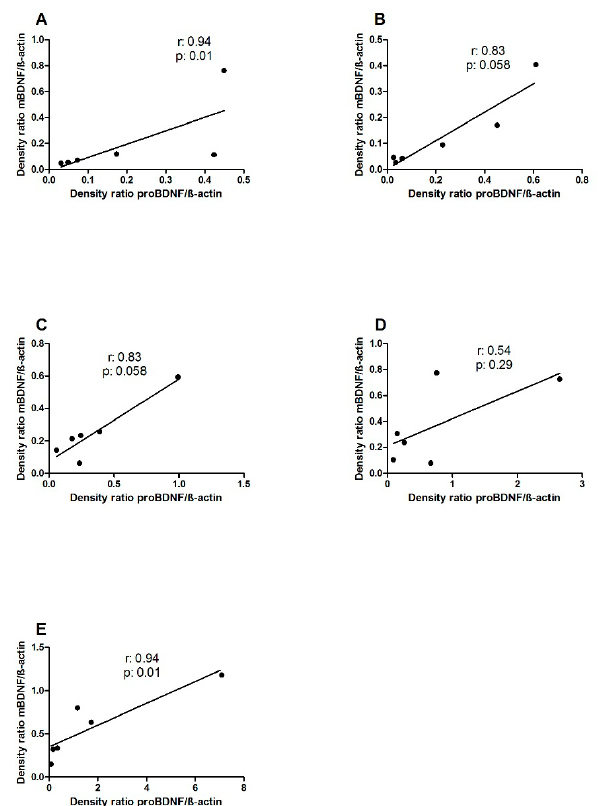
Figure 2. Correlation between proBDNF and mBDNF levels in brain samples from control and treated rats, each group consisting of six rats. A : Ctrl; B : PTG; C : L.GG; D : co-administered; E : pre-treated. Dots represent the values of at least three independent experiments. Data were analyzed by the Spearman Regression Test.